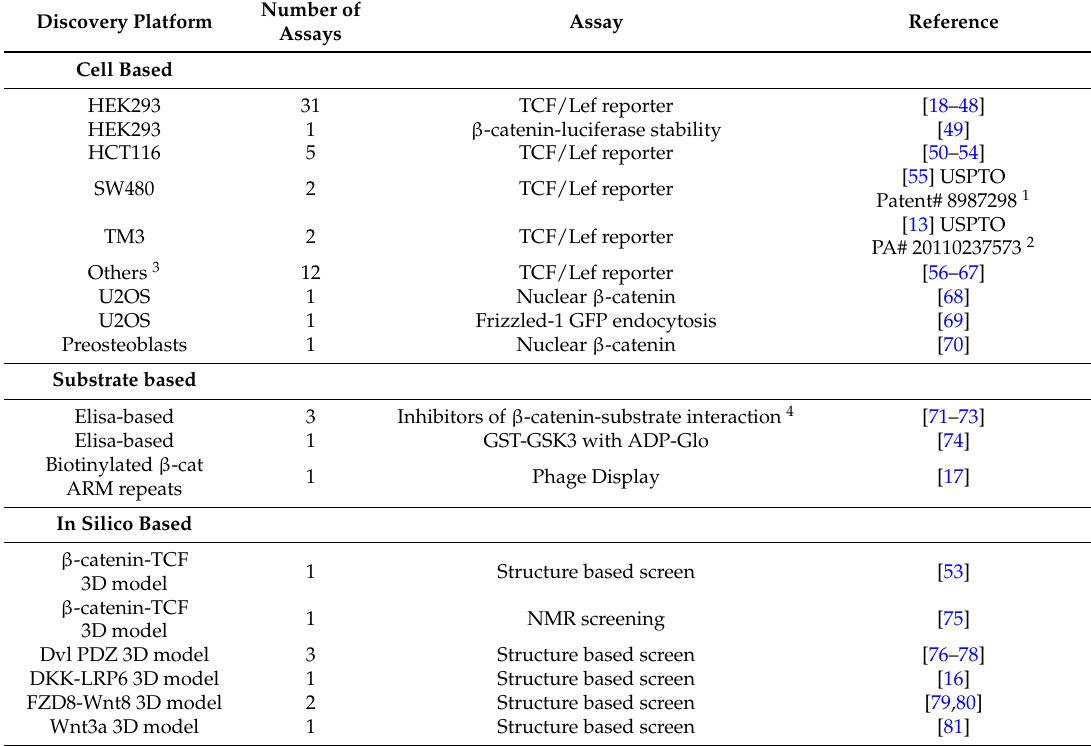
Table 8. Assays for discovering modulators of Wnt